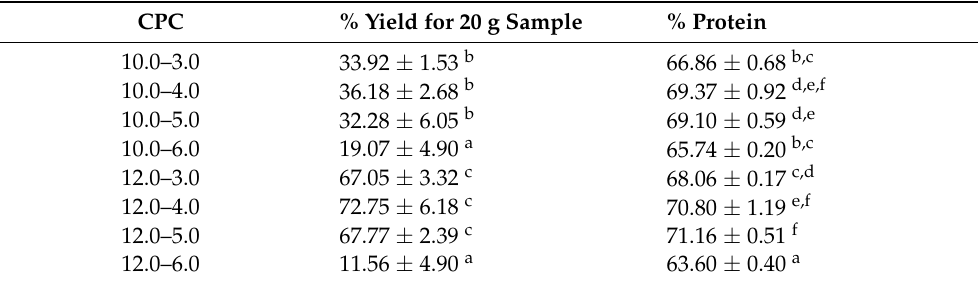
Table 2. % Yield of cricket protein concentrate (CPC) obtained at different pH of extraction and pHs of isoelectric precipitation and % protein of CPC by Dumas method.